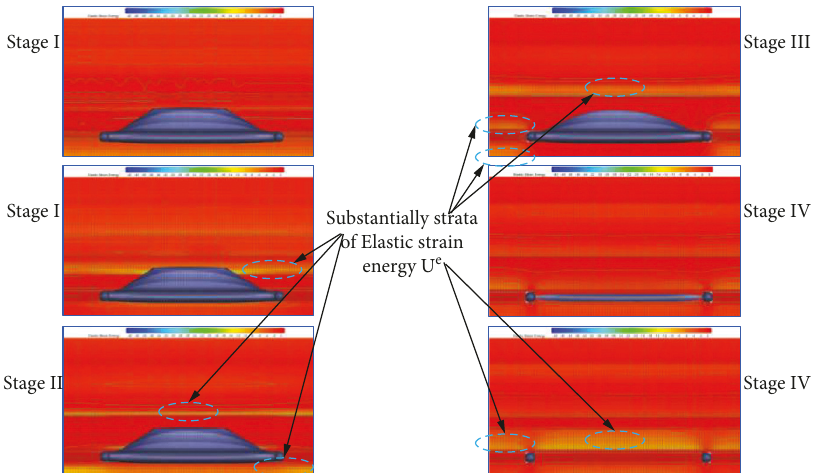
Figure 7: Evolution law of elastic strain energy field of stope surrounding rock at different stages of fault